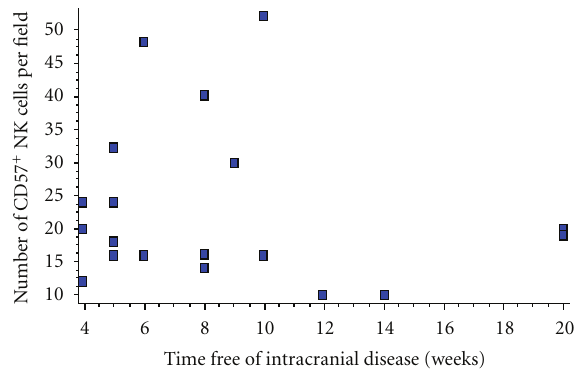
Figure 3: Correlation between the degree of CD57 + NK-cells in the resected metastasis and the time free of new intracranial metastatic disease in the cases of the series. Correlation was not found ( P = 0 . 63; correlation coe ffi cient ( r ): − 0.1128; 95% confidence interval (CI): − 0.52 to